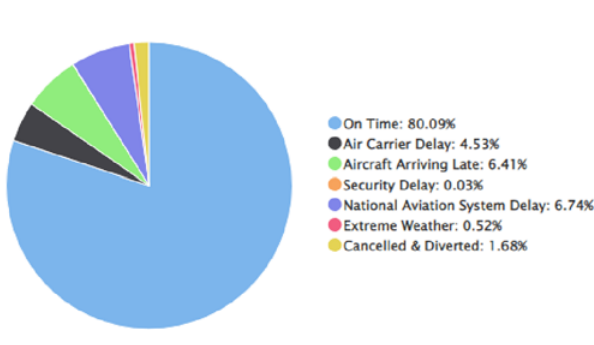
Fig. 1. Flight Delays by Cause - All Major Airports (January - December,